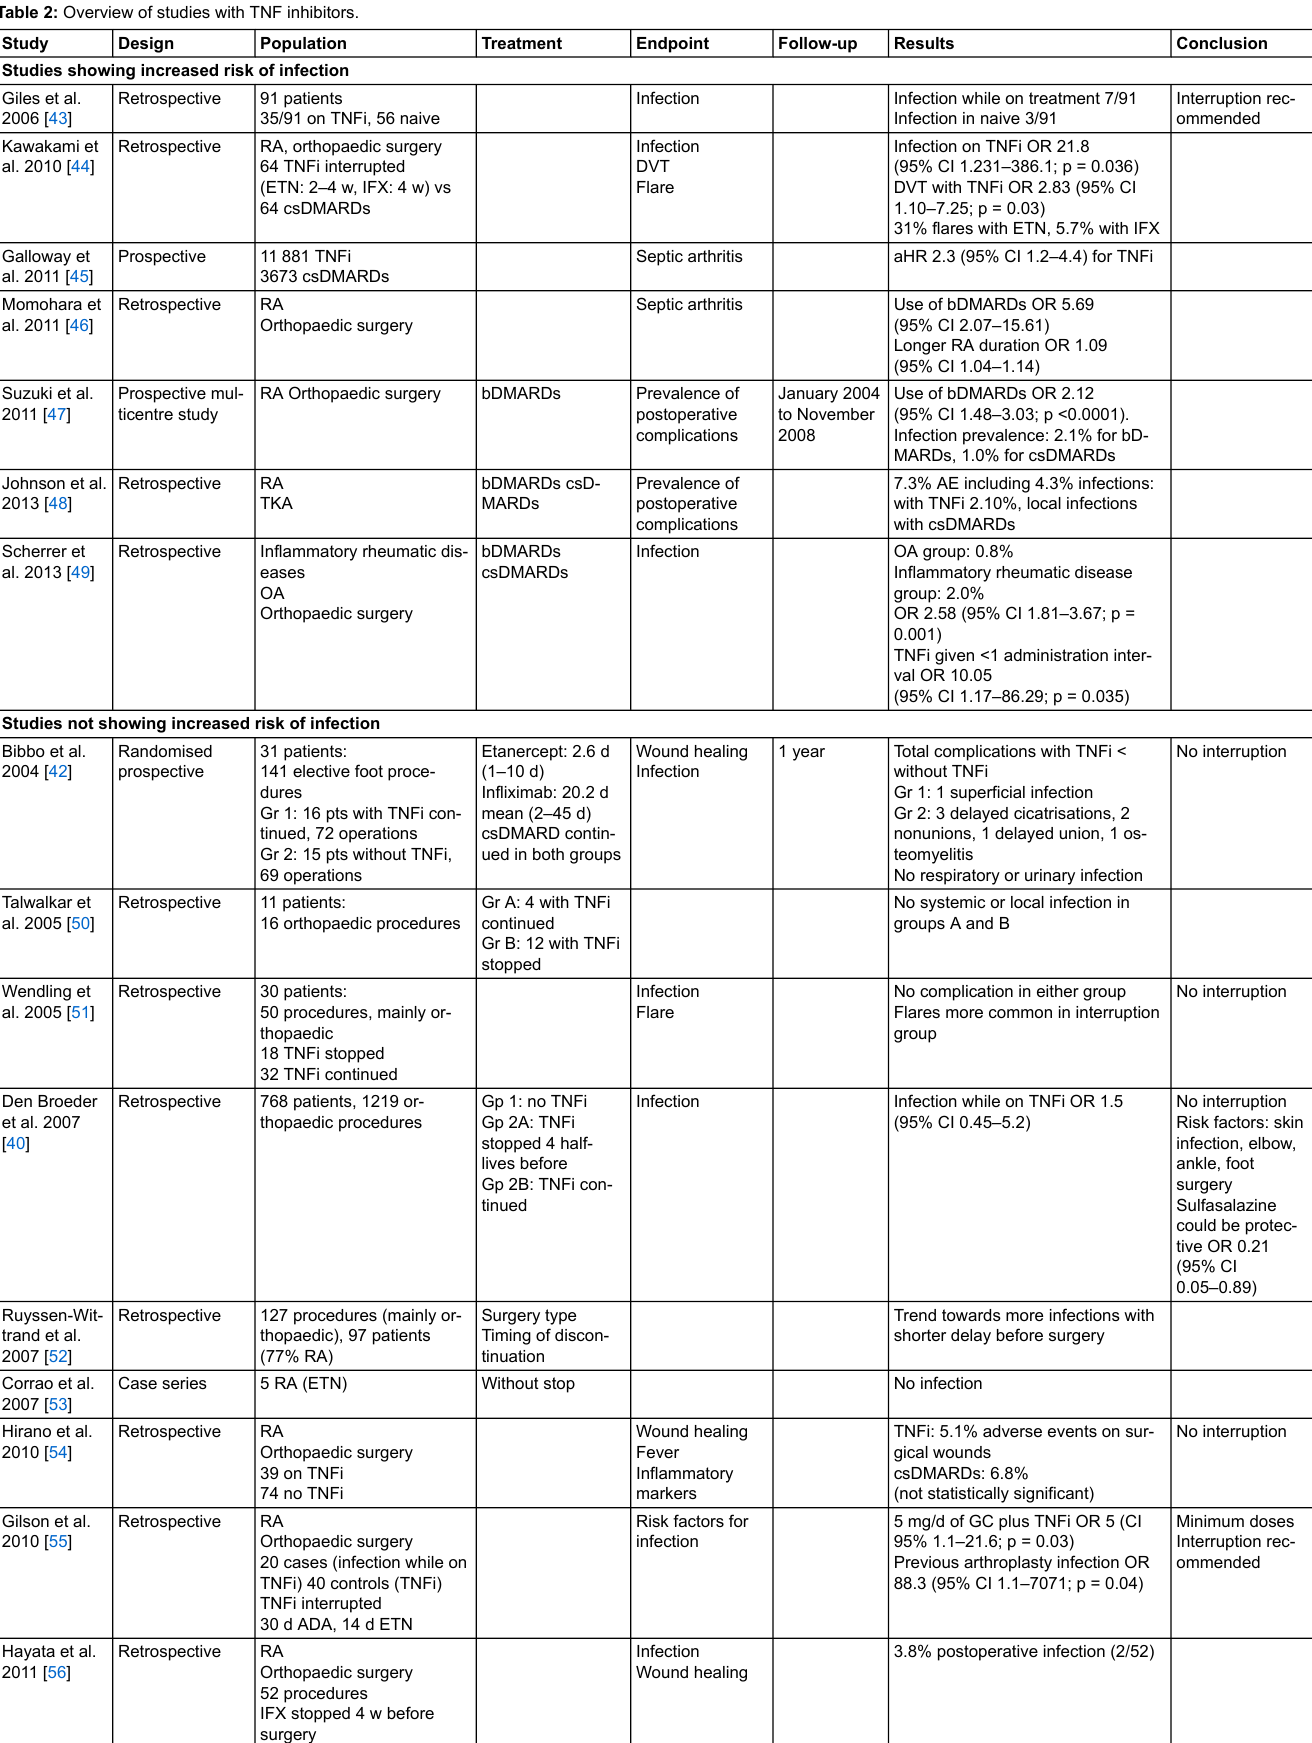
Table 2: Overview of studies with TNF